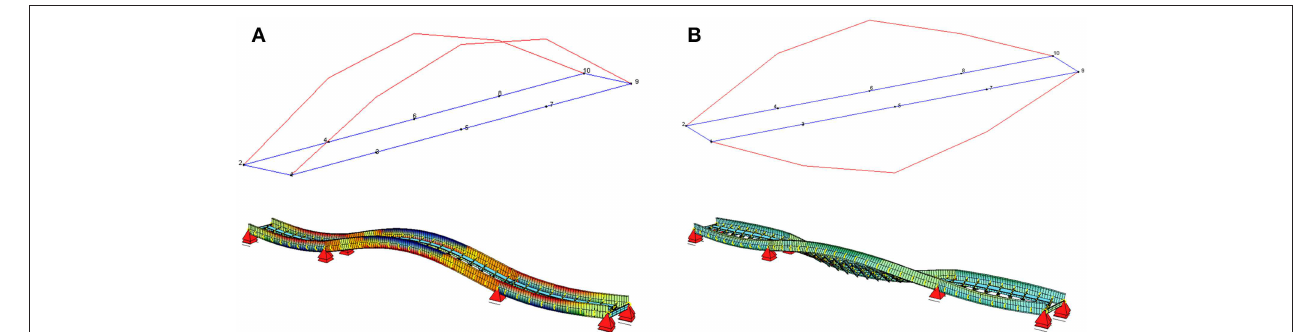
FIGURE 11 | Experimental and numerical mode shapes: (A) 1st mode shape; (B) 2nd mode shape.